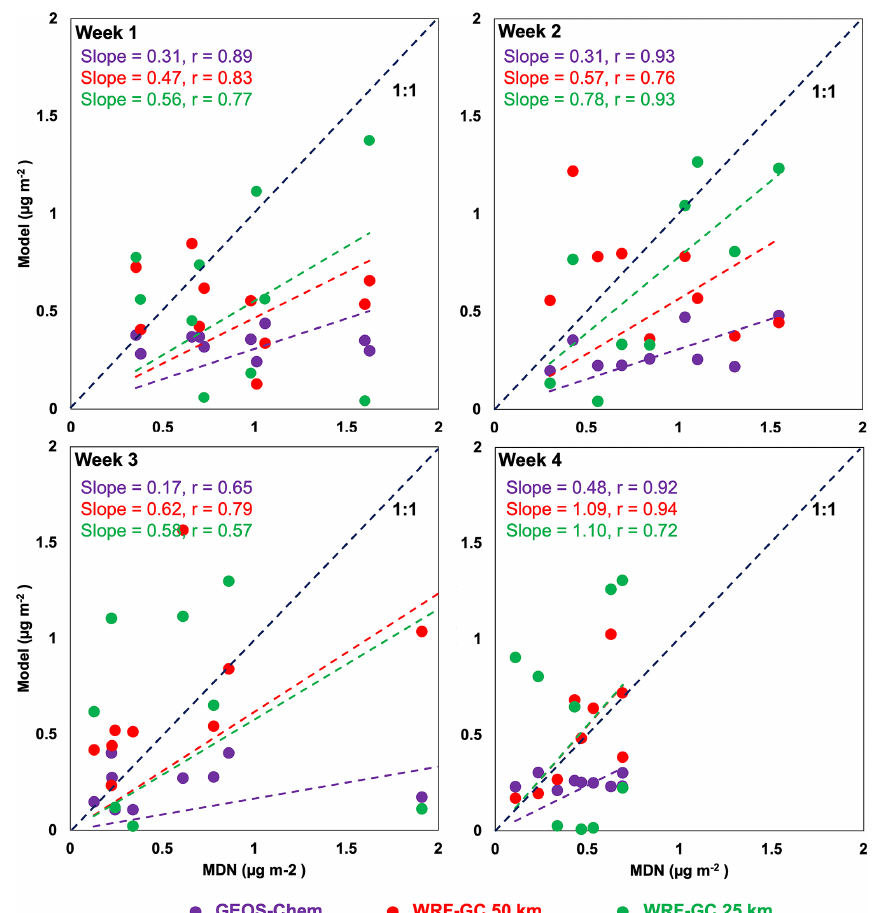
Figure 7. Comparison of correlation analysis of different simulations for 4 separate weeks at 12 high-value MDN